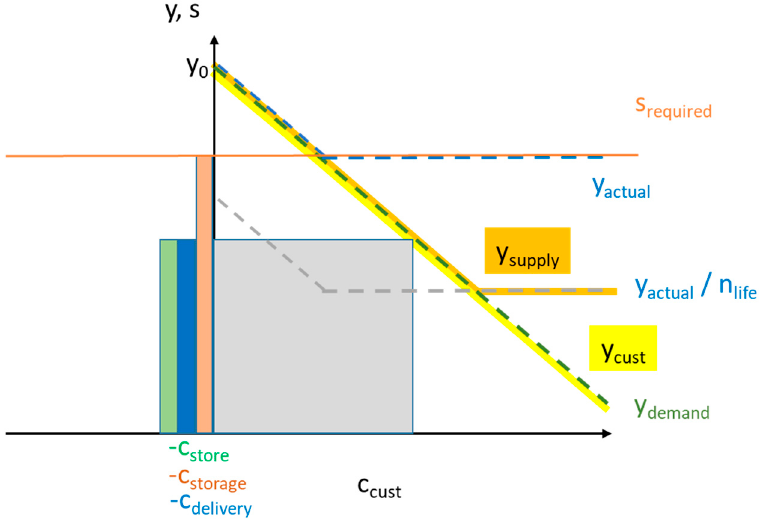
Figure A4. Optimal profit condition in zone 2.